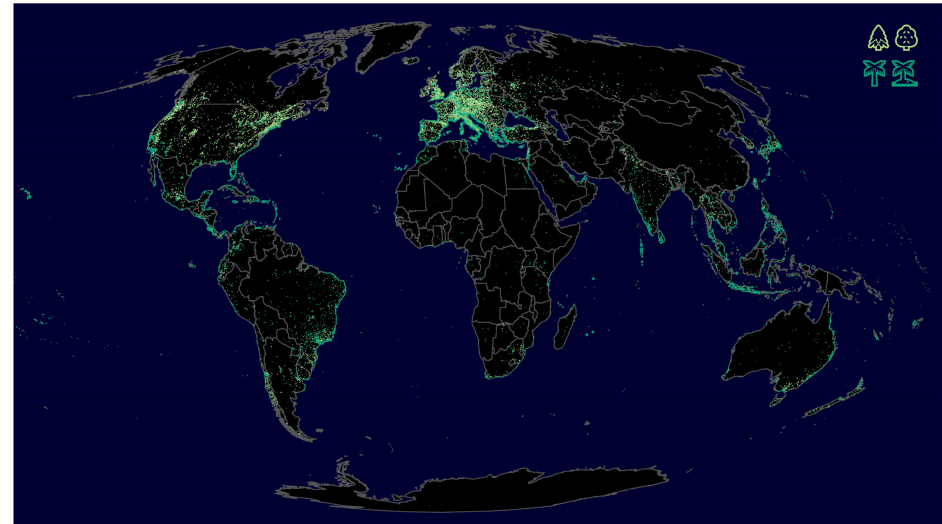
Figure 4. Global spatial distribution of location-specific emojis representing the predominant tree vegetation.